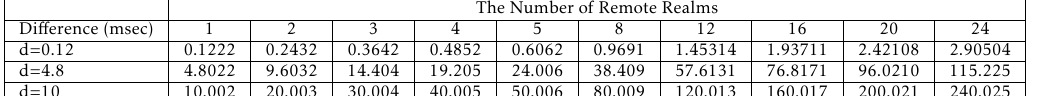
The Number of Remote Realms